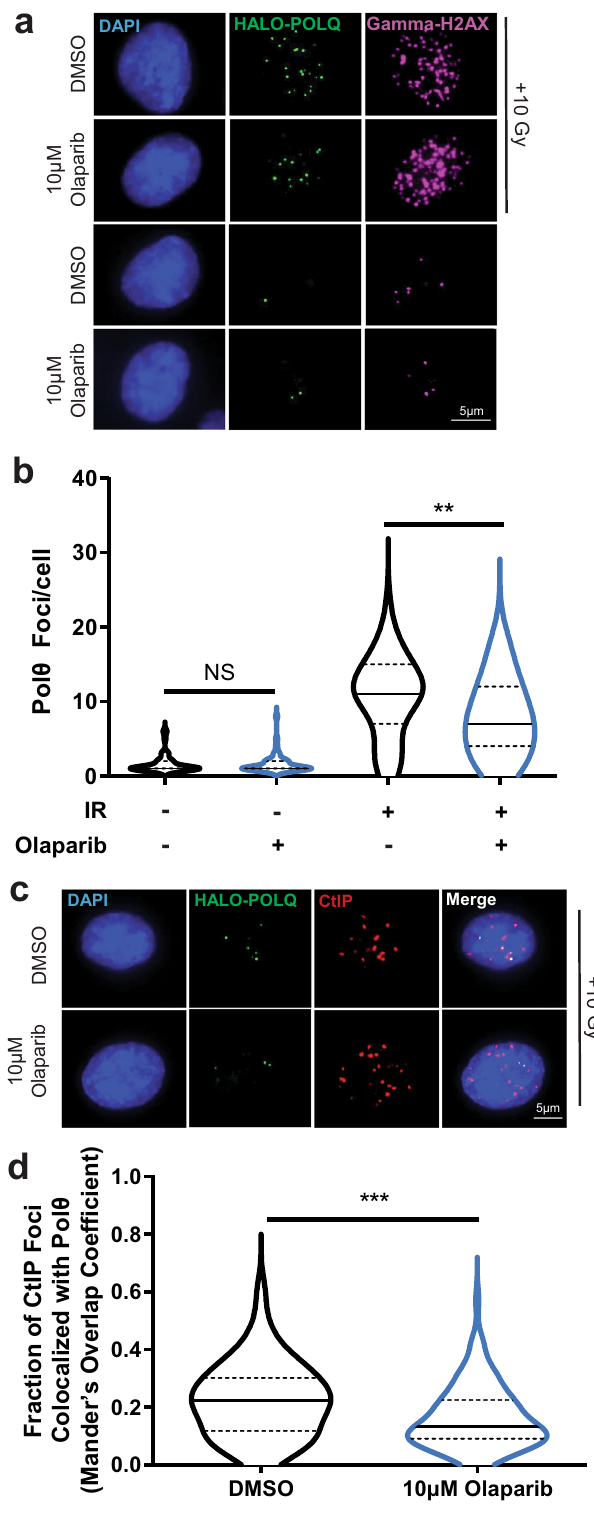
Fig. 4 | PARP activity promotes Pol θ foci formation and colocalization with CtIP.a Representativeimages,selectedfrom300imagedcells,ofHALO-POLQfoci (green) in DMSO- or olaparib-treated RPE-1 cells without damage or with damage induced by 10 Gray (Gy) of ionizing radiation (IR). DAPI (blue) marks nuclei, and GammaH2AX (pink) indicates damage. b Number of Pol θ foci per cell in cells with >0 foci (DMSO+IR n =55, olaparib+IR n =43, DMSO n =50, olaparib n =50). Sig- ni fi cance of difference determined by one-way ANOVA (NS, p >0.99, not sig- ni fi cant; ** p =0.0012). The distribution of foci/cell is represented by a truncated violinplotincludingmedian(solidline)andupperandlowerquartile(dashedlines) values. c Representative images, selected from 100 imaged cells, of HALO-POLQ (green) and CtIP (red) foci in irradiated RPE-1 cells. d Fraction of CtIP foci coloca- lized with Pol θ (Mander ’ s overlap coef fi cients; DMSO n =100, olaparib n =100). Signi fi canceofdifferencedeterminedbyunpaired,two-tailedt-test(*** p =0.0003). The distribution of foci/cell is represented by a truncated violin plot including median (solid line) and upper and lower quartiles (dashed lines)